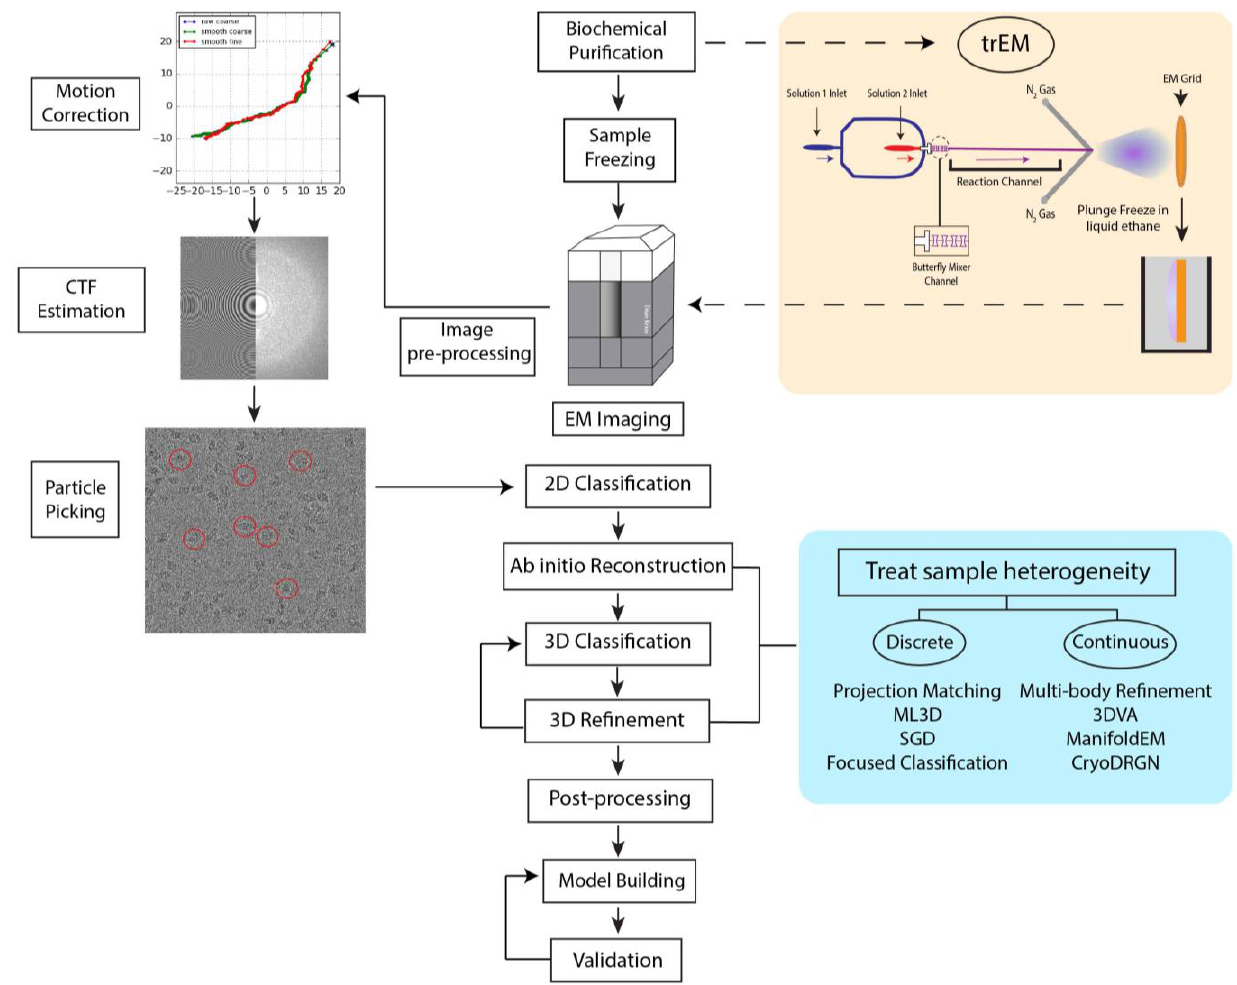
Figure 1. Schematic representation of a typical cryo-EM processing workflow. After biochemical purification, samples are rapidly plunge-frozen in liquid ethane and imaged in an electron microscope. In time-resolved cryo-EM (trEM) (orange box), biochemical reactions are frozen at different time points to elucidate structures of reaction intermediates. The schematic in the orange box depicts a microfluidic mixing-spraying method that utilizes a microfluidic chip to mix, incubate, and spray reactants onto a cryo-EM grid prior to plunge-freezing. The data is acquired with a cryo-electron microscope. The resultant data is processed in multiple stages, including image pre-processing, 2D and 3D classification, post-processing, and model building. Image pre-processing steps (left) include motion correction, CTF estimation, and particle picking, in which particles are selected for downstream processing. The selected particles are indicated by red circles. Following the 2D classification of particle images, various strategies can be employed to resolve sample